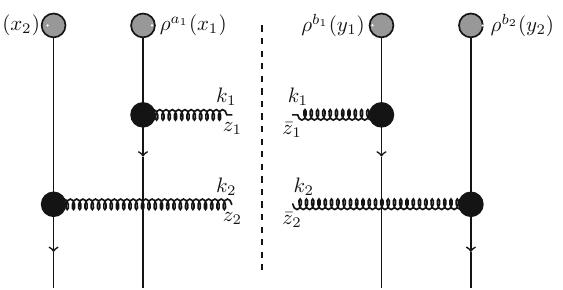
Fig. 1 Graphical illustration of Eq. (1) with the vertical lines repre- senting the rescatterings with the target through Wilson